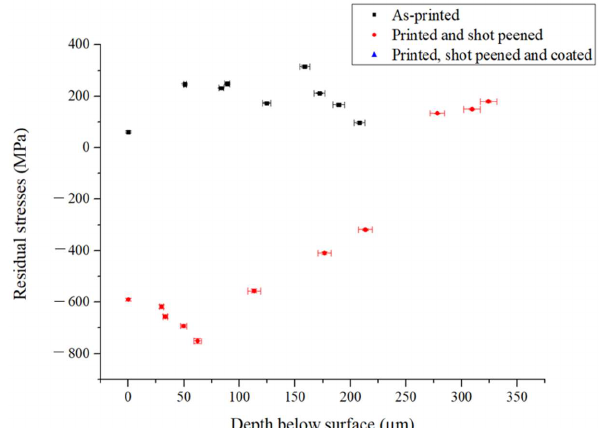
Figure 9. Residual stresses for the AP and PSP against the material depth removed.